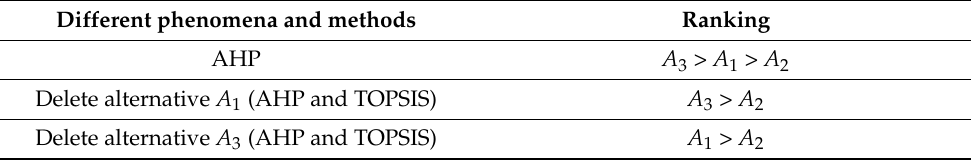
Table 9. The rankings of alternatives under different phenomena and